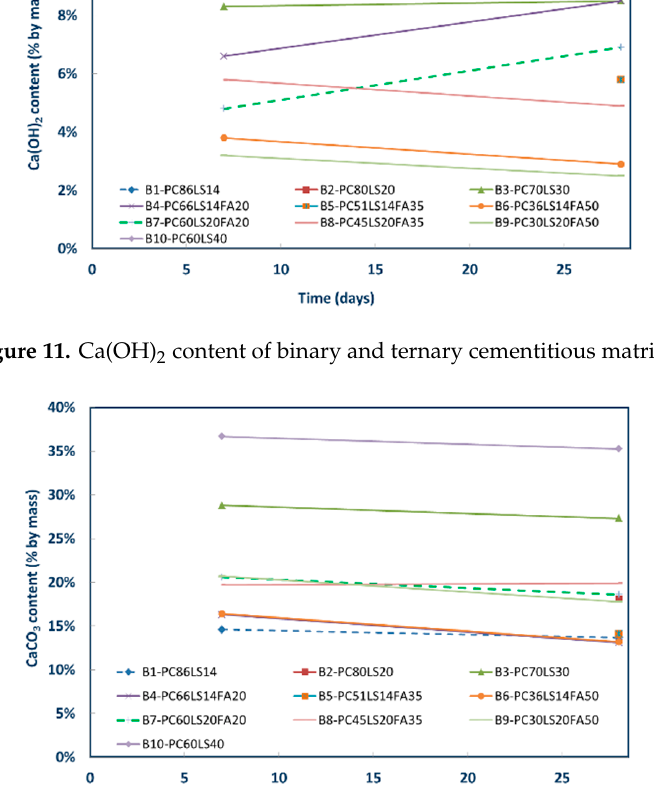
Table 7. Comparison of the Ca(OH) 2 content of the selected bases.